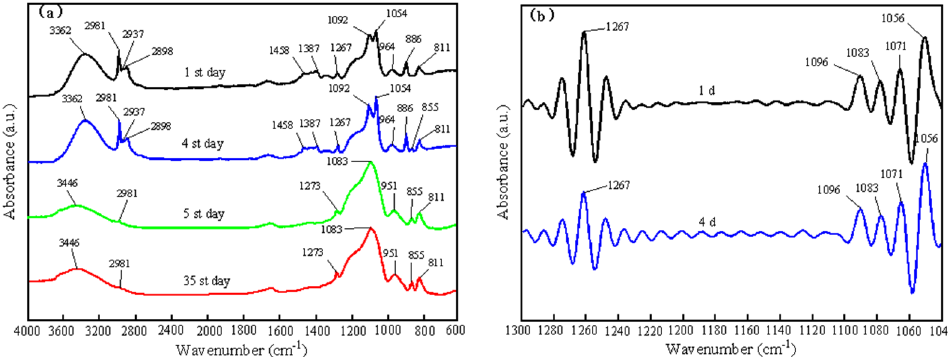
Figure 4. FTIR spectra. ( a ) FTIR spectra of sol-gel curing at 1, 4, 5, and 35 days. ( b ) Fourier self- deconvolution infrared spectra of sols cured at 1040 cm − 1 to 1300 cm − 1 for 1 and 4 days.